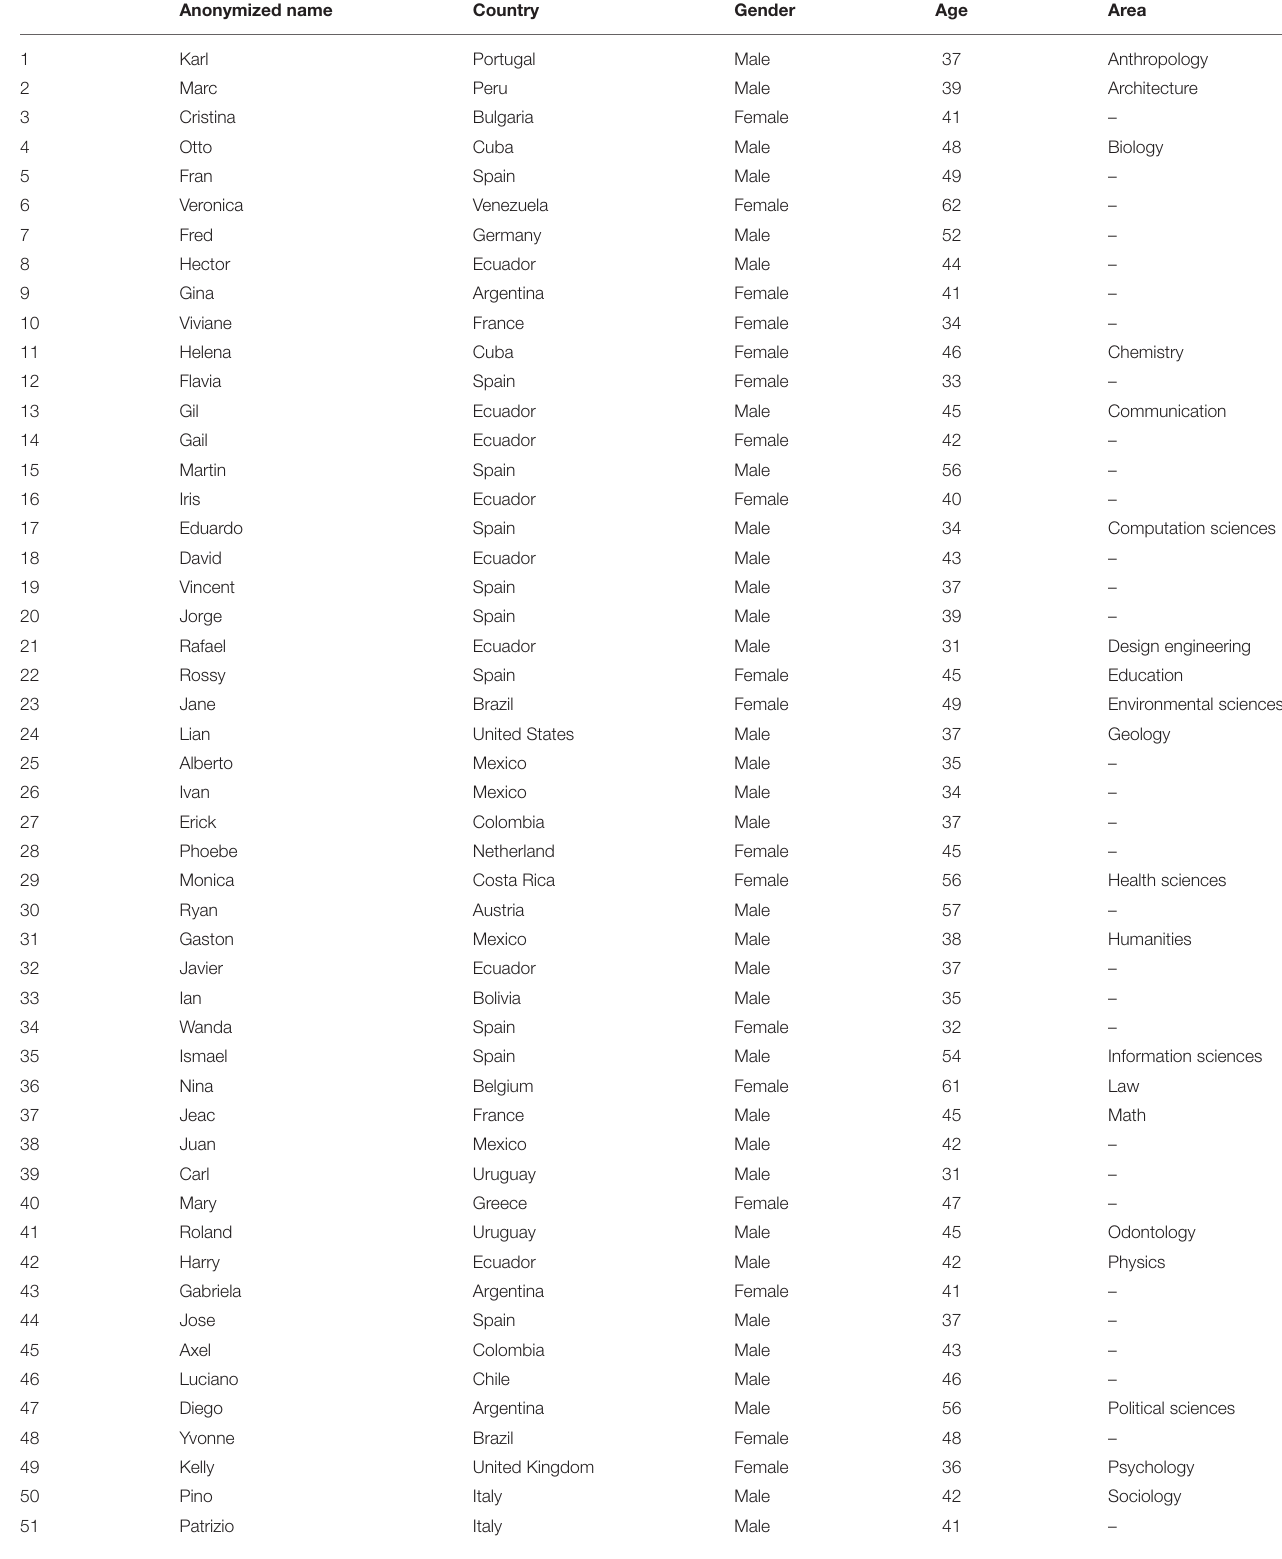
TABLE 1 | Main characteristics of